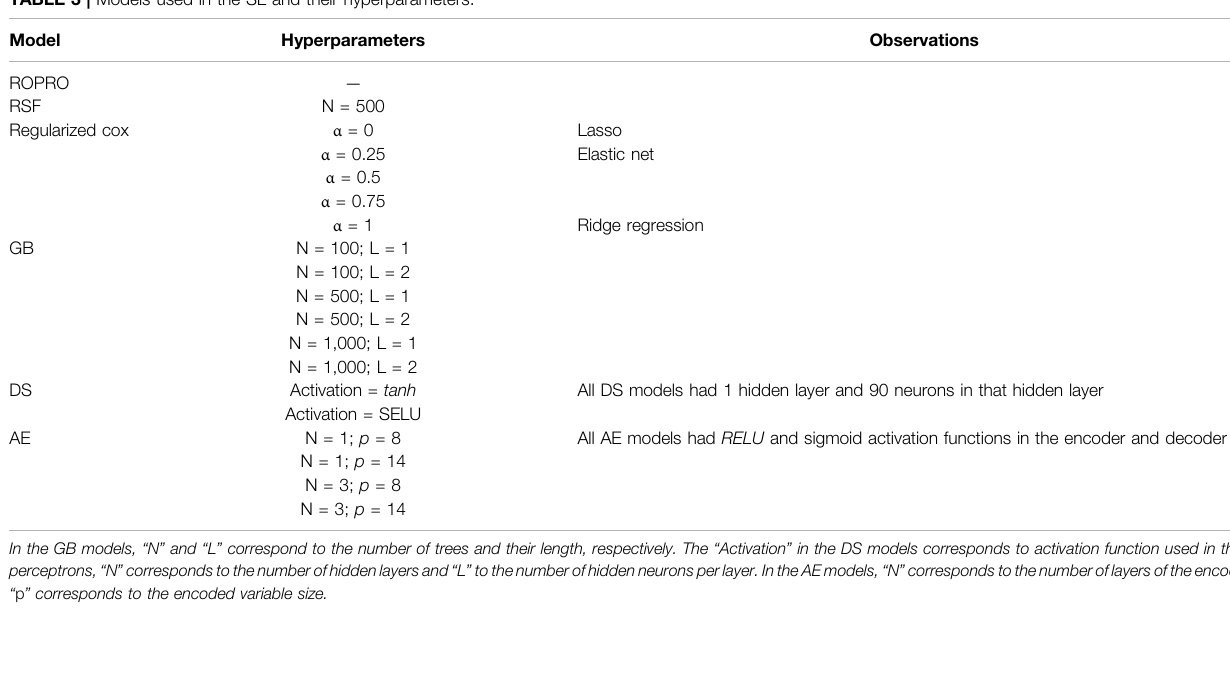
TABLE 3 | Models used in the SL and their hyperparameters.